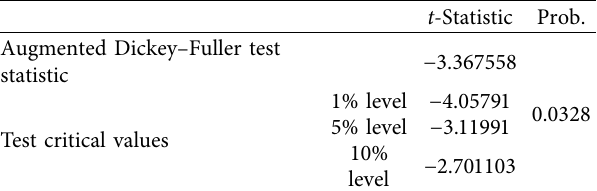
Table 6: ADF test of first-order difference of residential expected sales